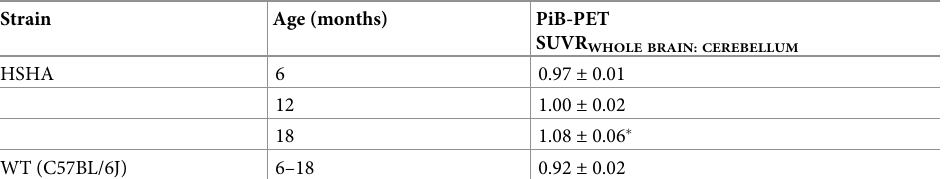
Table 1. SUVR values of 11 C PiB in WT and HSHA mice.